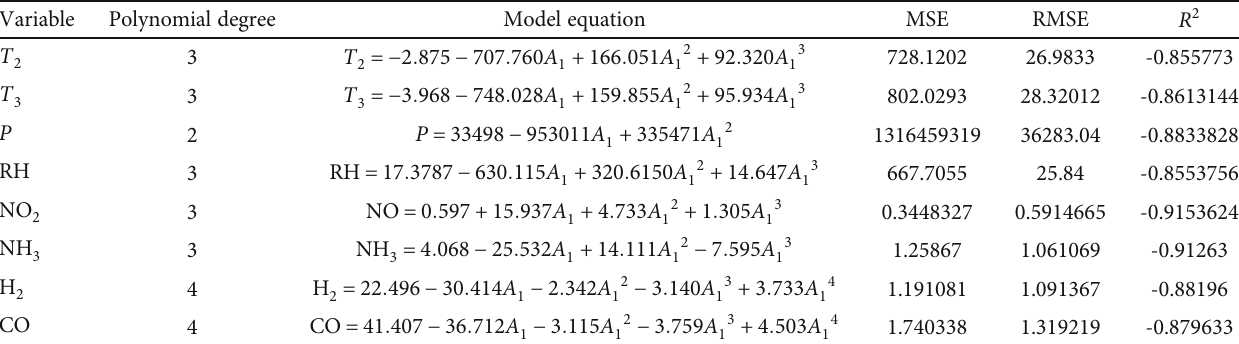
Table 9: Local polynomial regression equations for dependent variables by the altitude